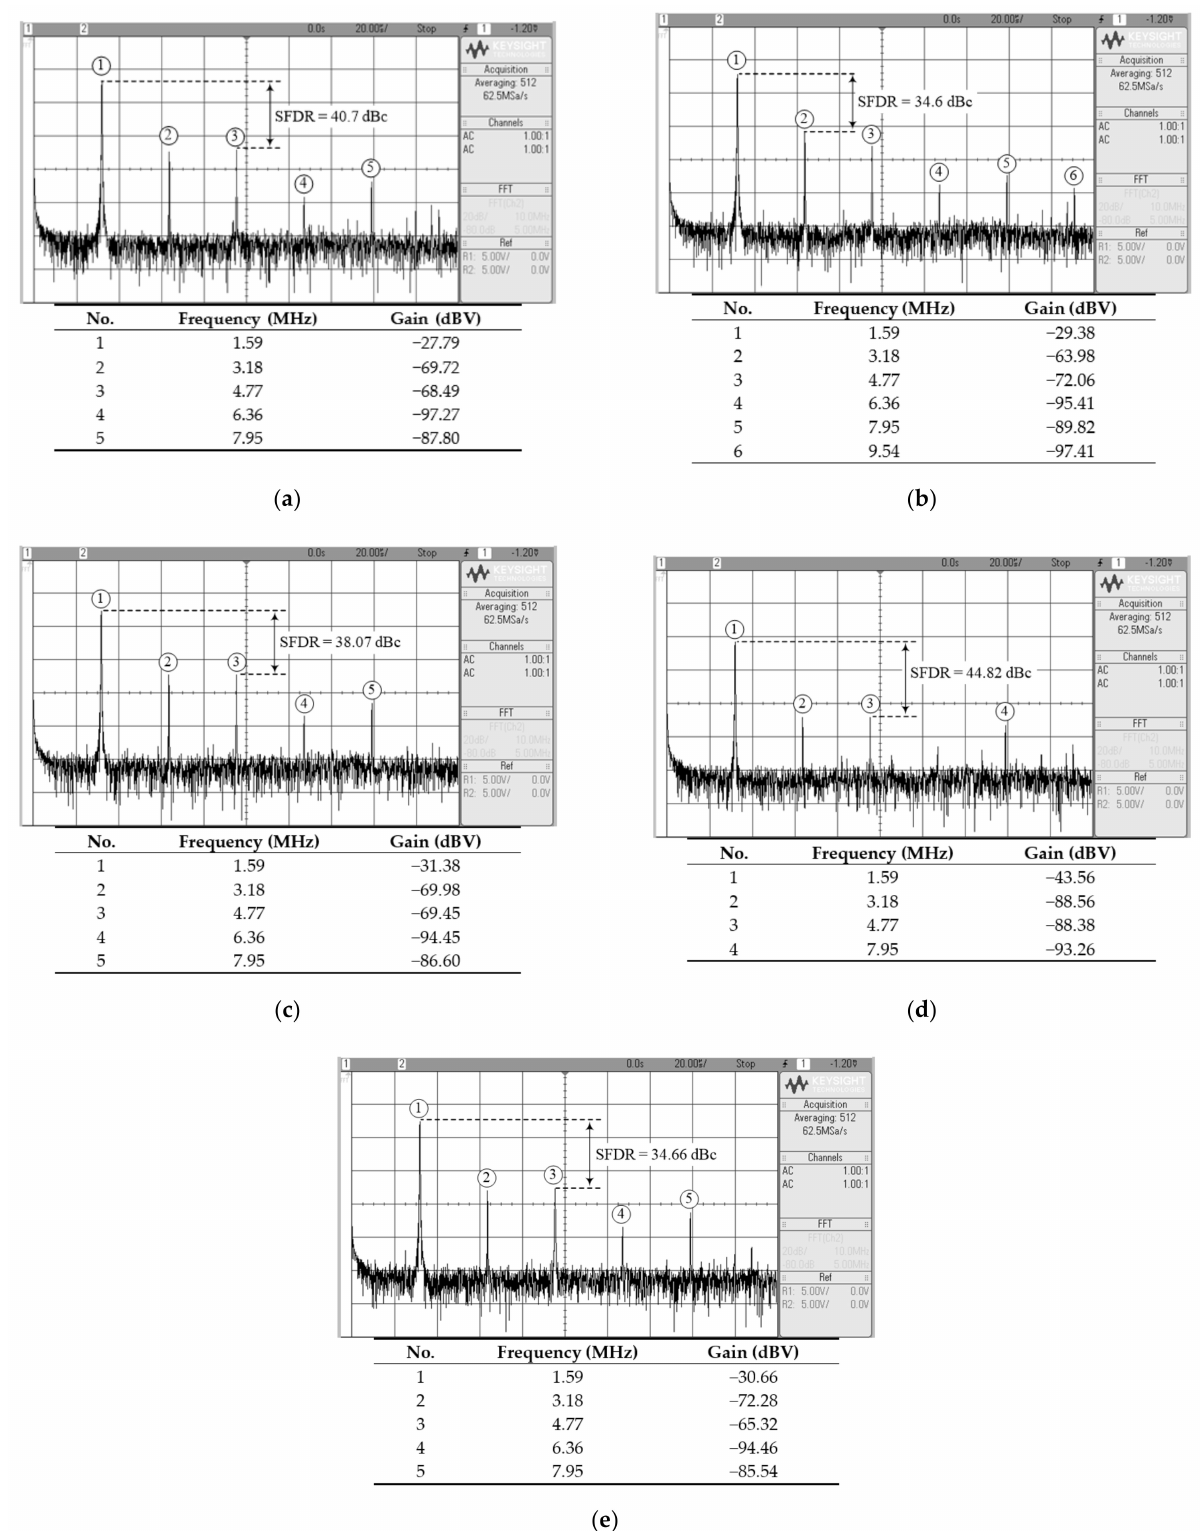
Figure 19. Measured frequency spectrum of v out of the proposed VM filter: ( a ) LP; ( b ) BP; ( c ) HP; ( d ) BS; ( e )